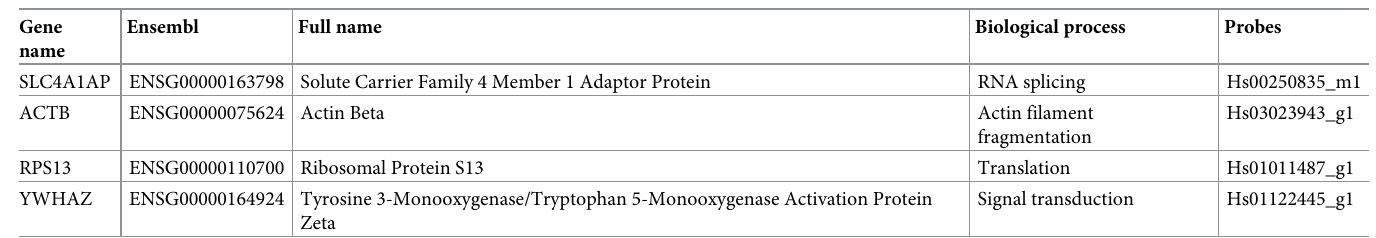
Table 2. Candidate RG for PCR